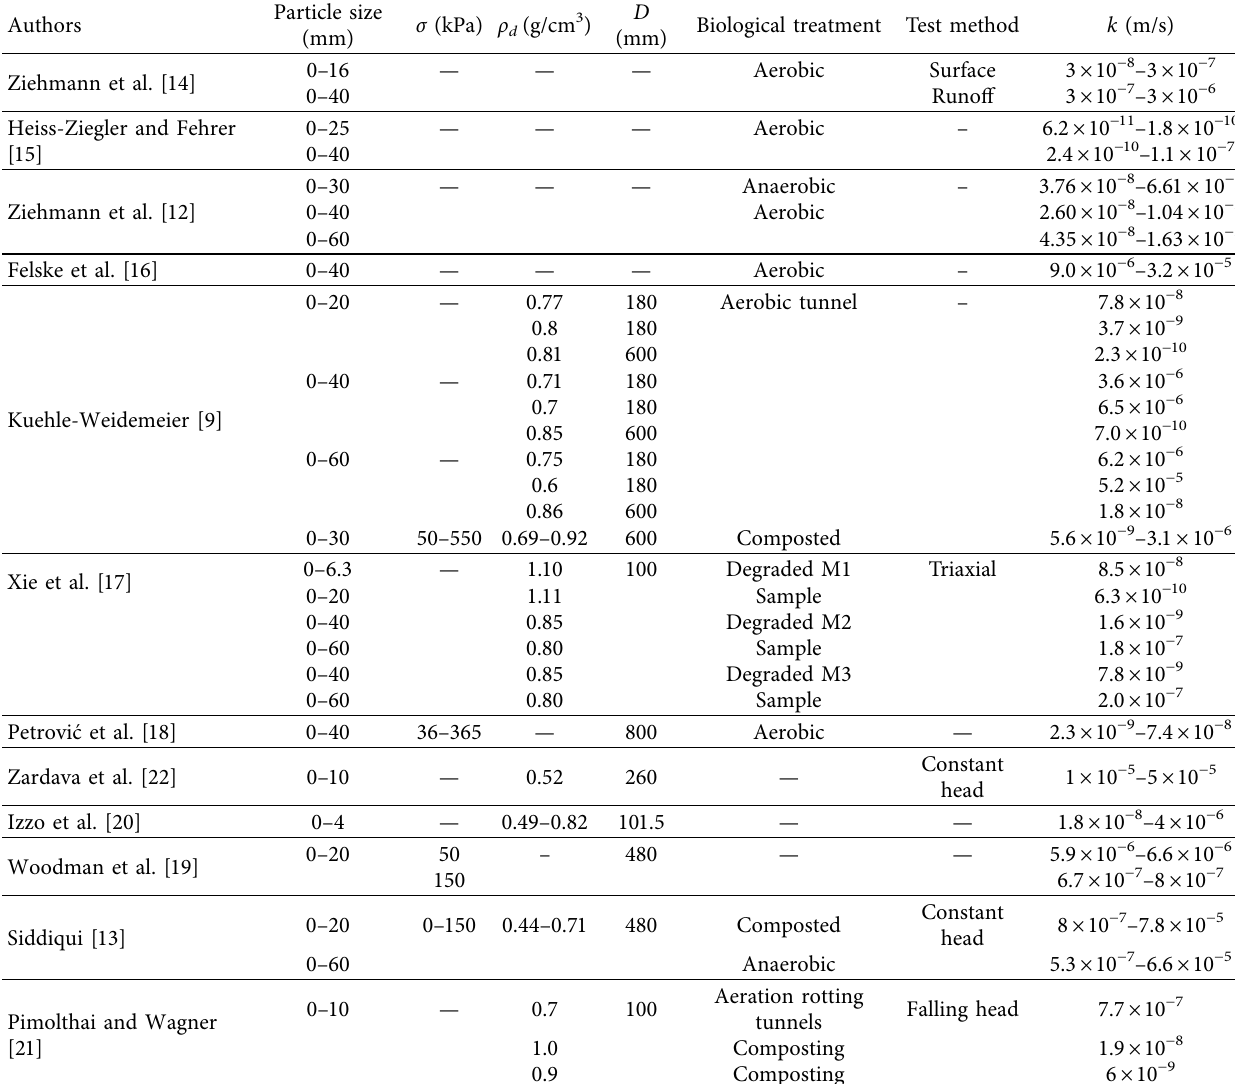
Table 1: Permeability of MBT waste with different particle